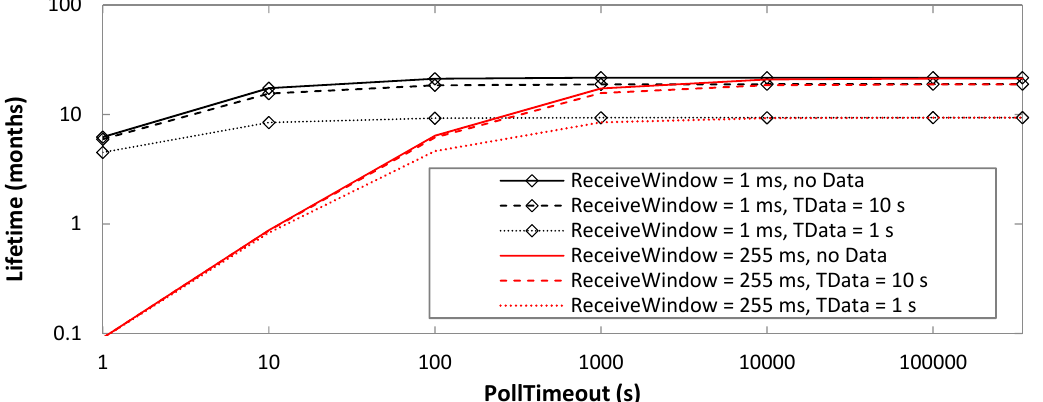
Figure 10. BM-LPN lifetime, as a function of PollTimeout, in absence of data message transmissions, and for different ReceiveWindow settings.